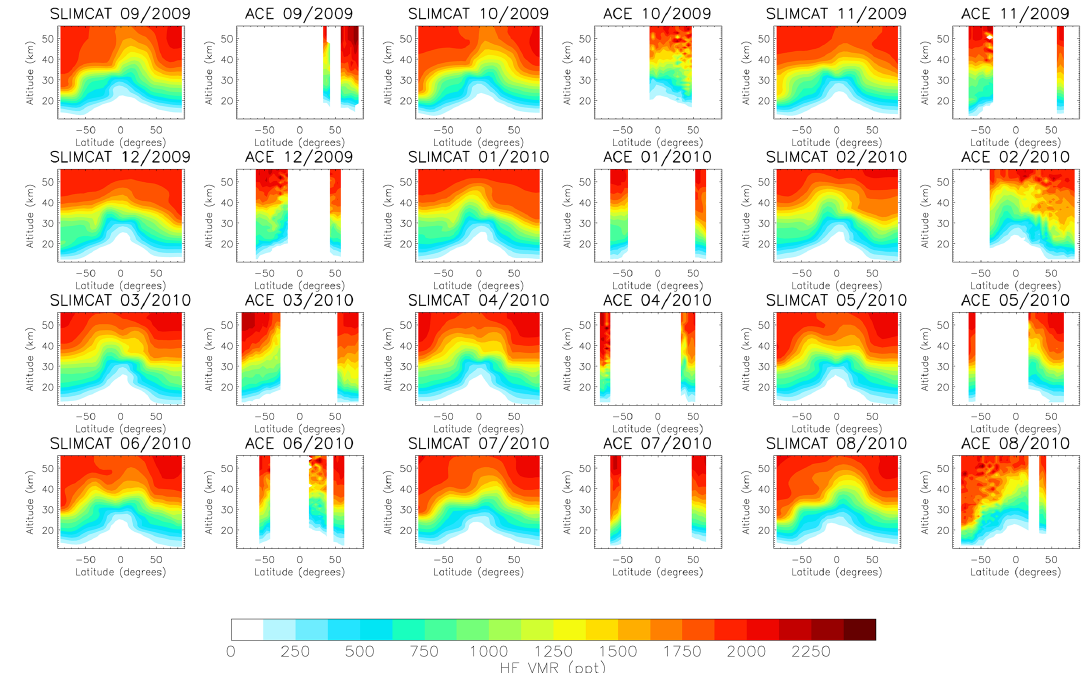
Figure 1. A comparison between ACE-FTS and SLIMCAT HF zonal means (September 2009 to August 2010). A full discussion of the seasonal variation in the HF distribution is provided in the